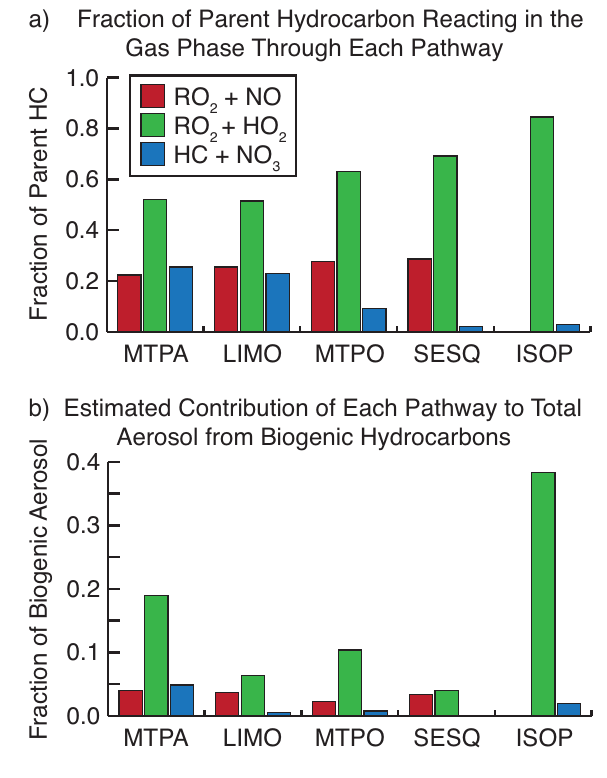
Fig. 2. Fraction of parent hydrocarbon reacting through each SOA- forming pathway globally and annually averaged (a) . All iso- prene photooxidation is labeled as low-NO x (RO 2 +HO 2 ) since the aerosol yields are representative of those conditions. Isoprene (ISOP) reaction with ozone is not shown since it does not produce aerosol. Panel (b) shows the estimated contribution of each parent hydrocarbon-oxidant pathway to total biogenic aerosol globally and annually averaged. Panel (b) is estimated using the aerosol yield for each system at an organic loading of 1.5µg/m 3